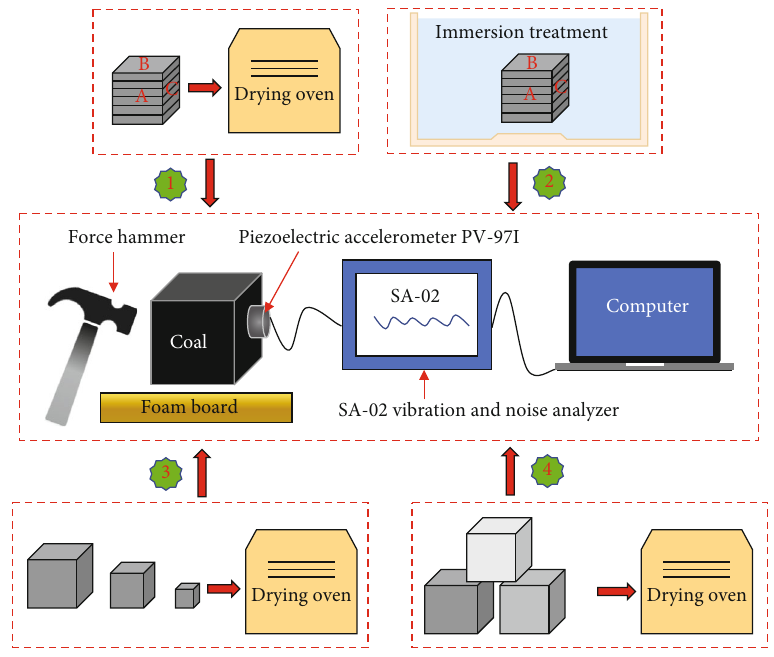
Figure 5: Experimental schemes and fl